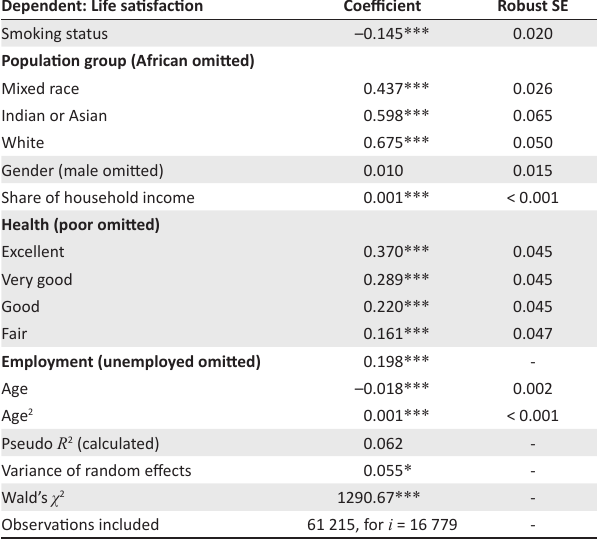
TABLE 6: Ordered probit (RE) regression results.